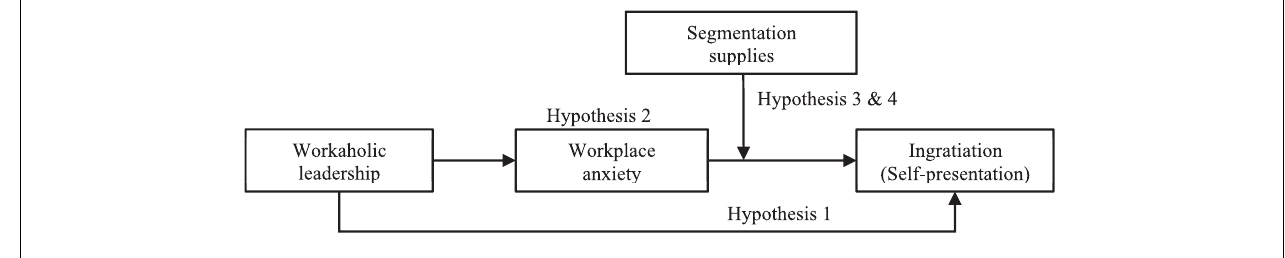
FIGURE 1 | Theoretical